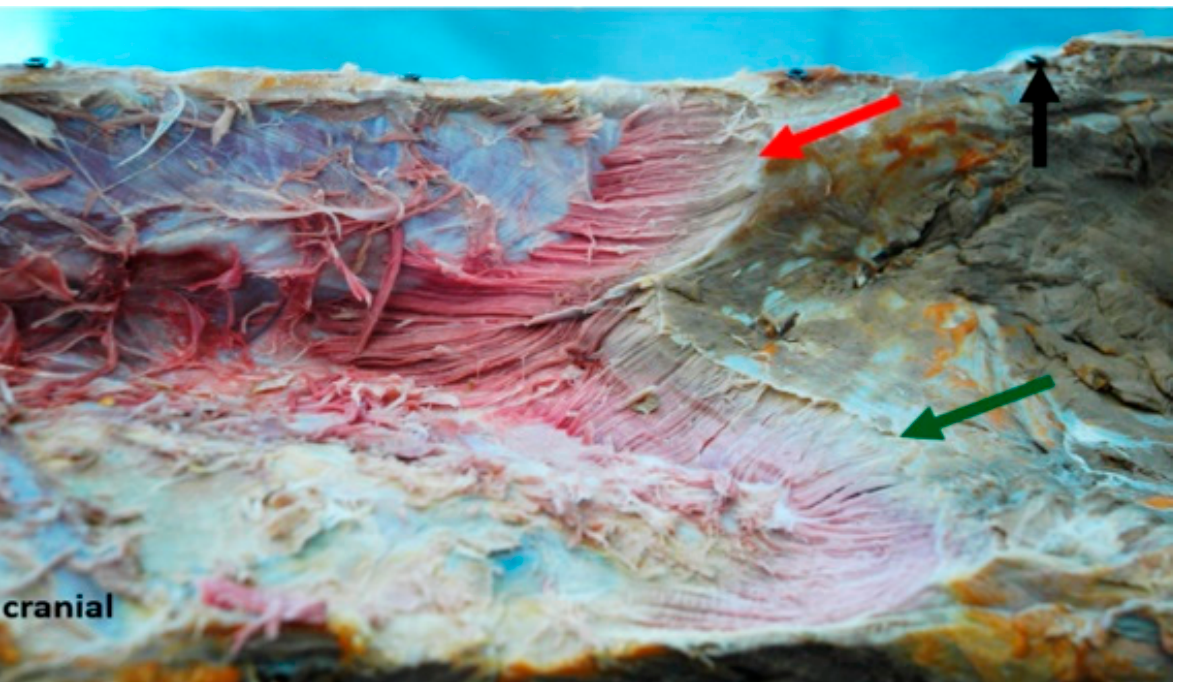
Figure 3. Left cranio-lateral view of a formalin-fixed horseback, showing the partly dissected lumbar LG at the height of the 16th rib (compartment C ). The green arrow is pointing at a screw drilled into the spinous process of the 15th thoracic vertebra, serving as a reference point during computed tomography (CT) scan and digitisation process. Muscle layers have been ablated from cranial to caudal to expose MFB from their origin to the insertion. The strong aponeurosis releases a fascia (black arrow) that divides the muscle partly into a supra- and subfascial belly.